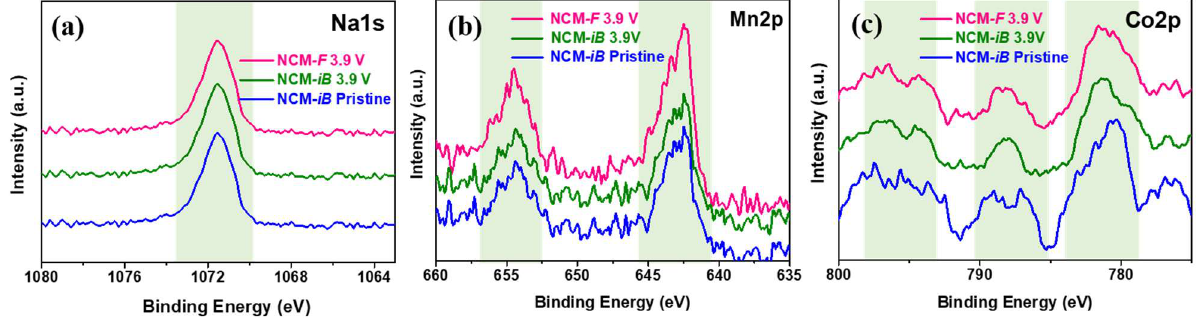
Figure 8. Ex-situ XPS spectra of the NaCM- iB and NaCM -f cathodes: ( a ) Na1s, ( b ) Mn2p, and ( c ) Co2p spectra.